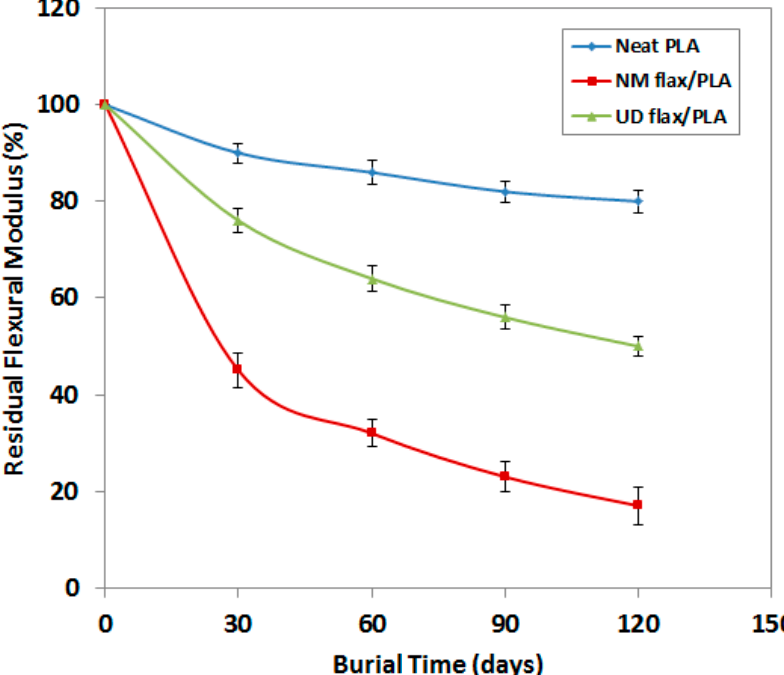
Figure 13. Comparative residual flexural modulus of biodegraded composites.